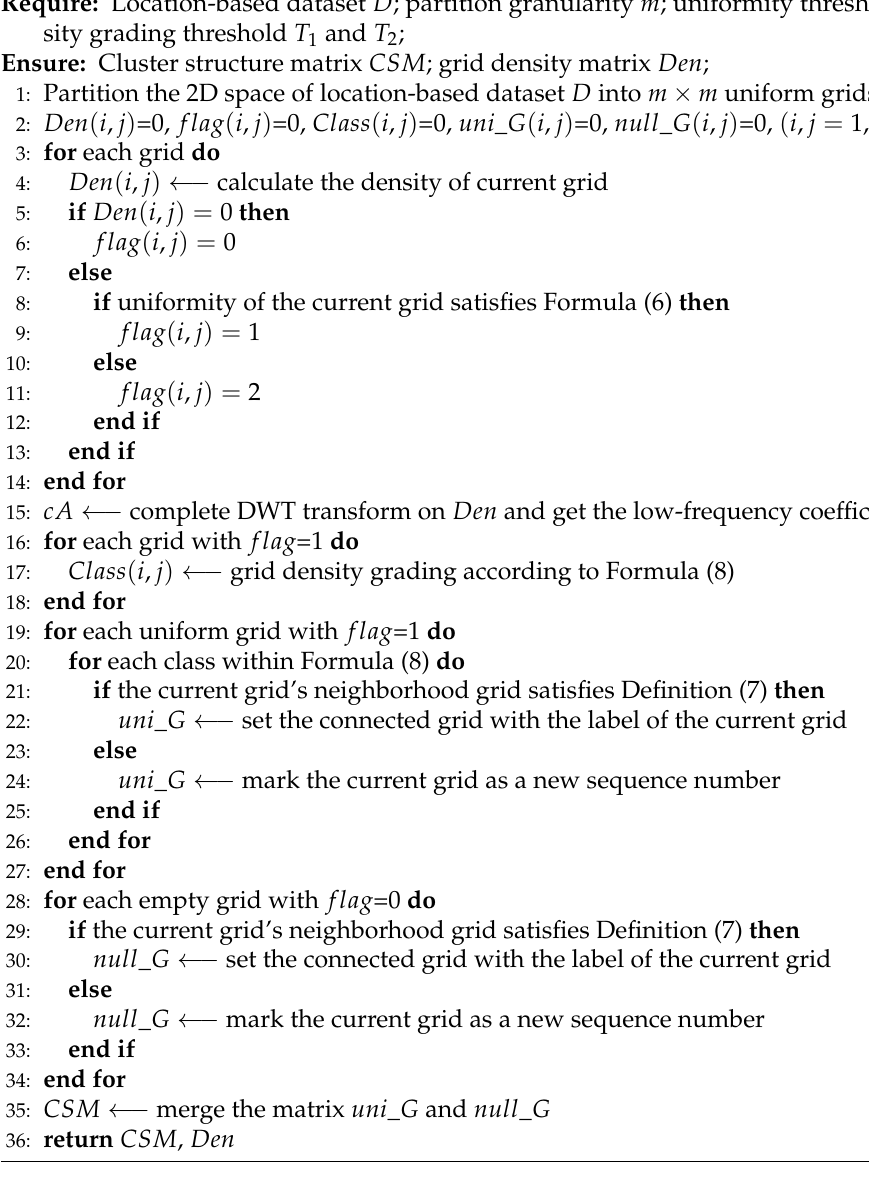
Algorithm 1 Grid clustering